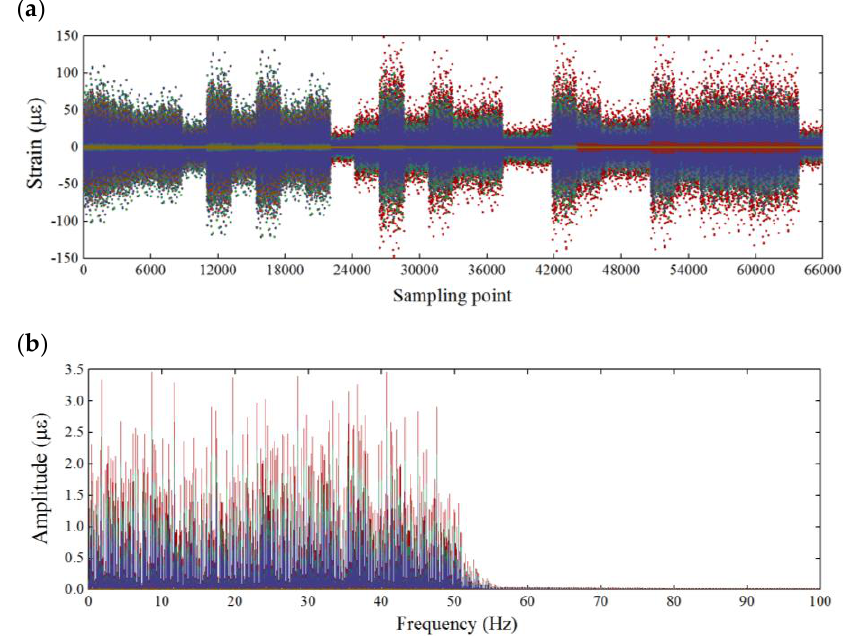
Figure 5. Raw strain monitoring data with the time-varying loads shown in ( a ) time domain and ( b ) frequency domain.